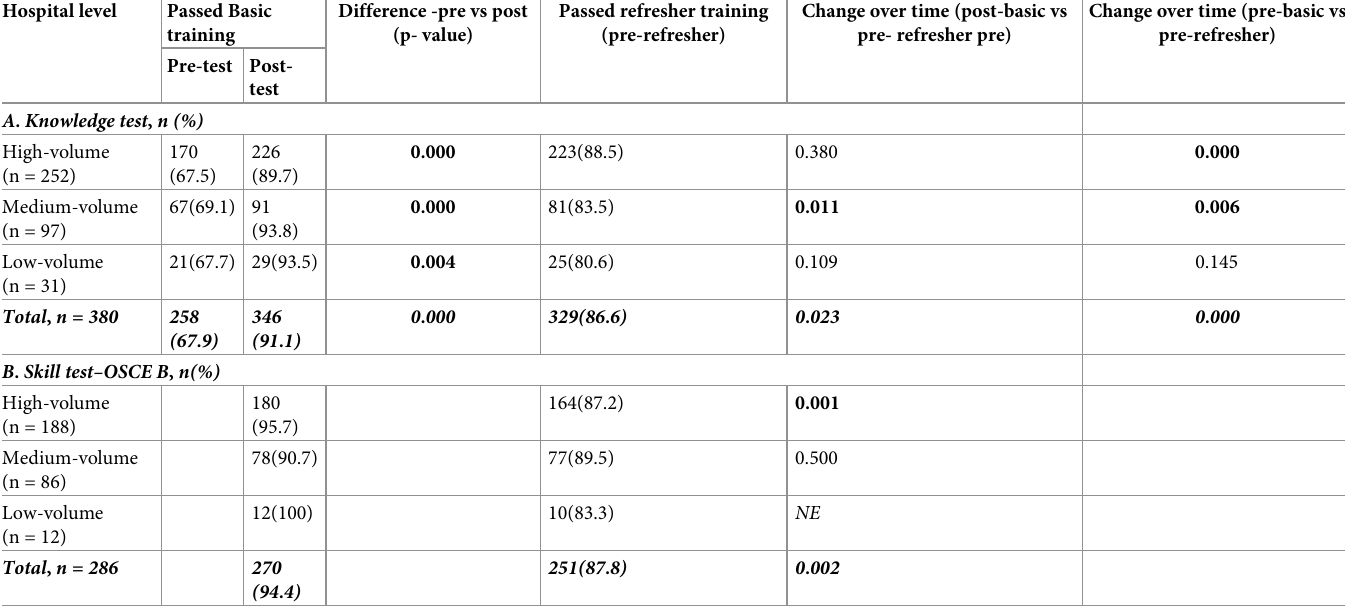
Table 3. Training outcomes knowledge and skill test for trainees by volume of